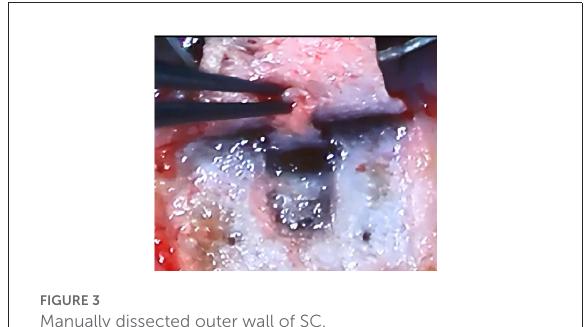
FIGURE1 Laser-ablated outer wall of SC.